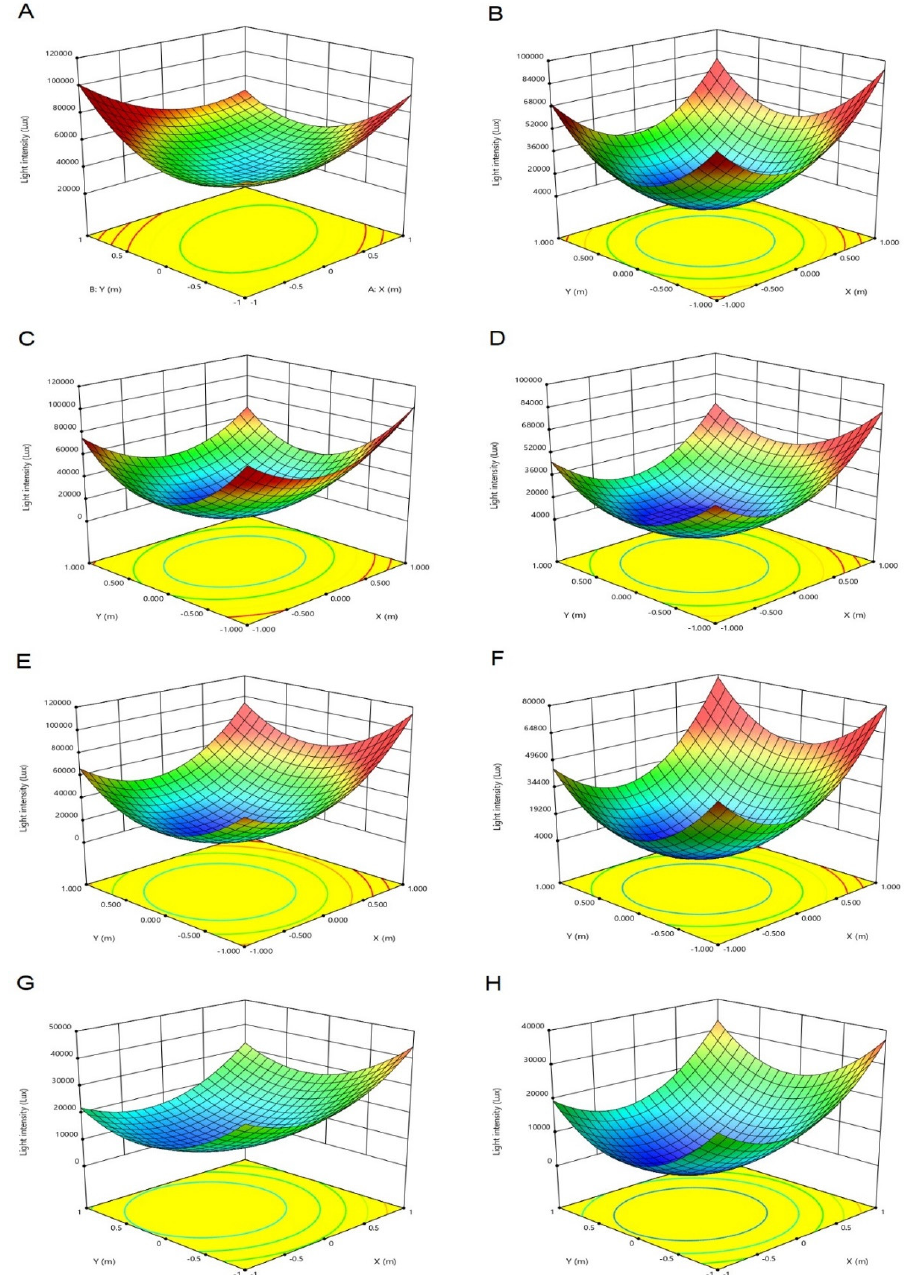
Figure 8. Spatial–temporal distribution of light intensity in canopies from July to October. The Y -axis is the distance in the east ( − ) and west (+) directions from the trunk (m); the X -axis is the distance in the south (+) and north ( − ) directions from the trunk (m); the Z -axis shows the light intensity. ( A , B ) show the light intensity distributions in the lower and upper layers of the canopy in July; ( C , D ) show the light intensity distributions in the lower and upper layers of the canopy in August; ( E , F ) show the light intensity distributions in the lower and upper layers of the canopy in September; and ( G , H ) show the light intensity distributions in the lower and upper layers of the canopy in